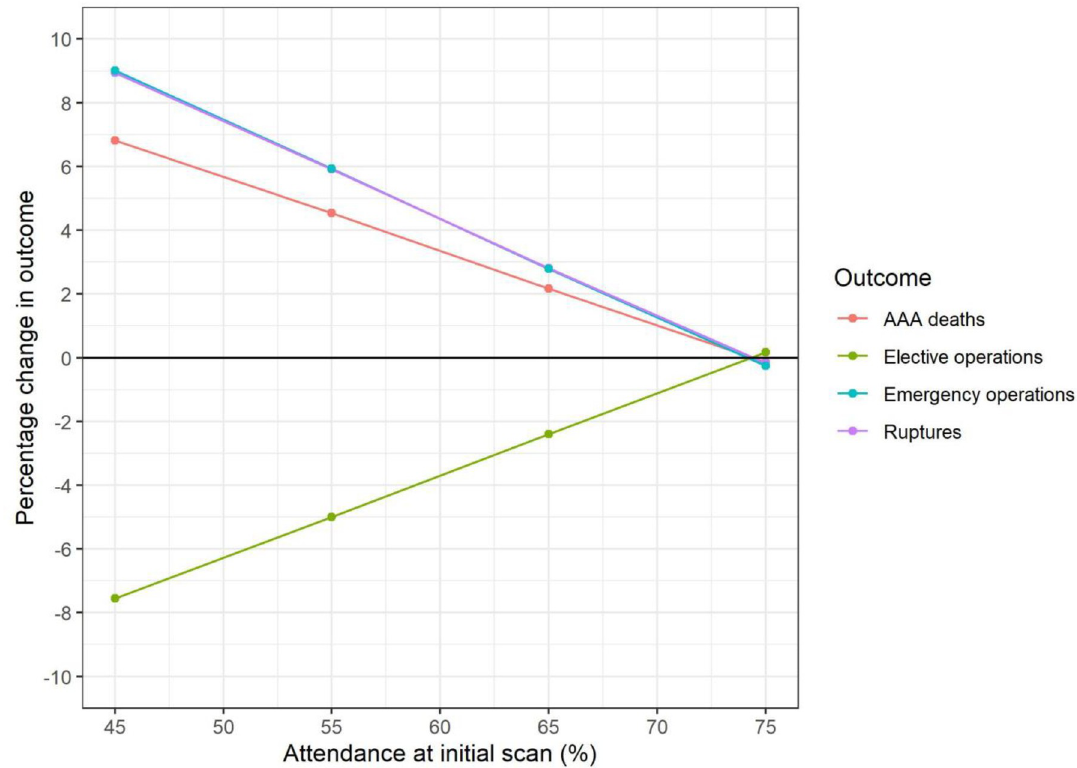
Fig 2. 65-year-old cohort: Change in key outcomes over varying attendance at primary scan (model I2).